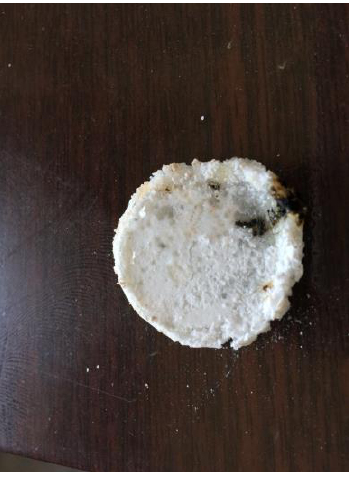
Figure 9. The image of (PEG) 10 LiClO 4 after